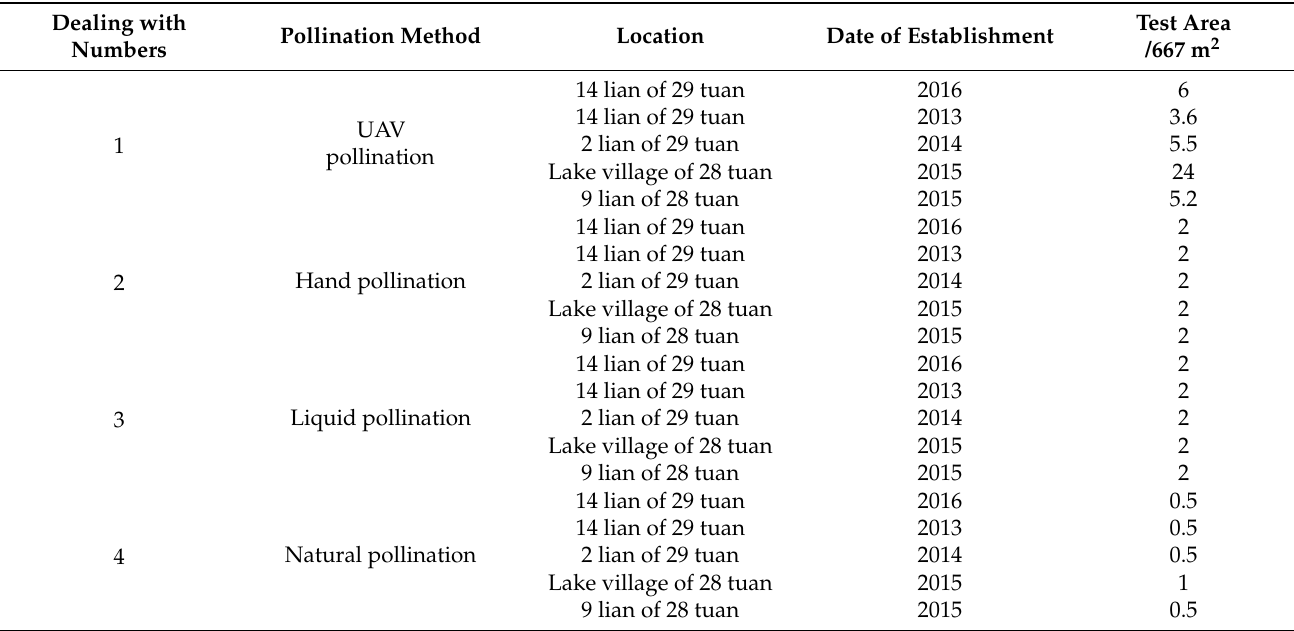
Table 3. Field validation trial